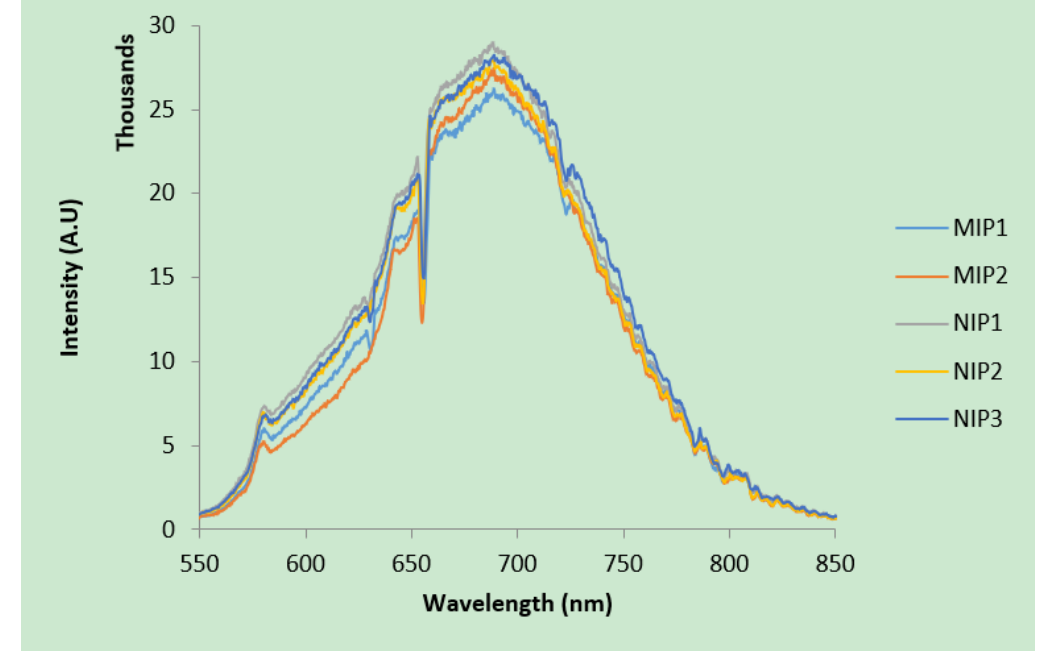
Figure 5. Comparison of emission from similar nanodiamond clusters of 4.8 ± 0.2 μm